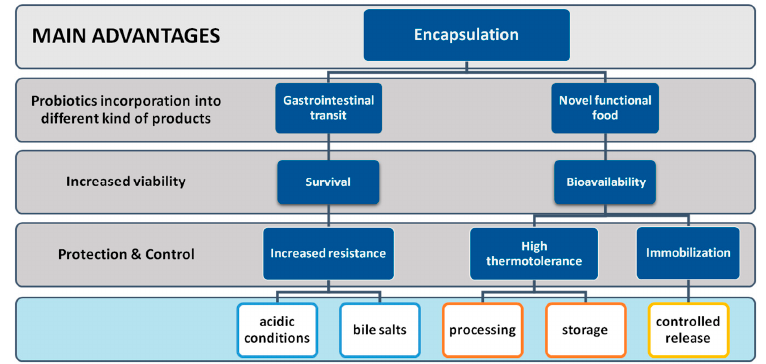
Figure 3. Schematic presentation of the main advantages of probiotics encapsulation.